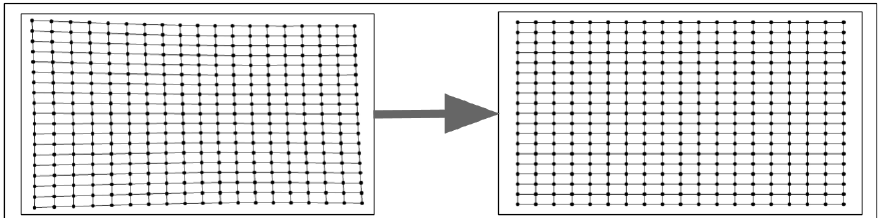
Figure 20. Distortion correction.